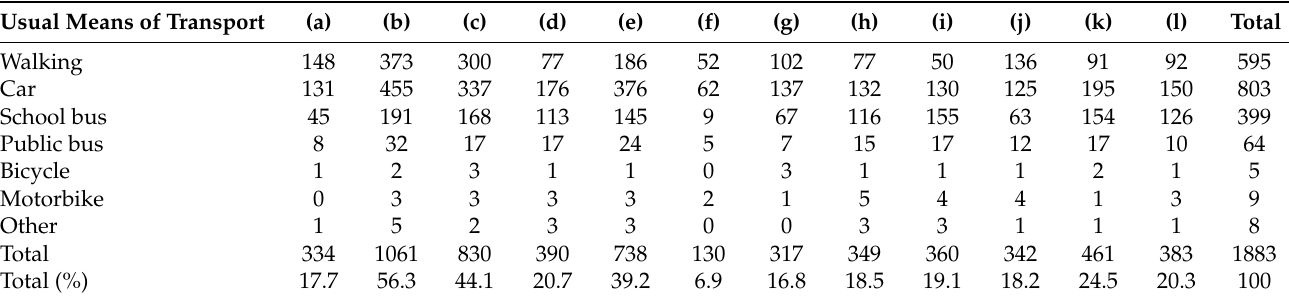
Table 7. Elements found on home–school routes. (a) Wide sidewalks; (b) crosswalks; (c)